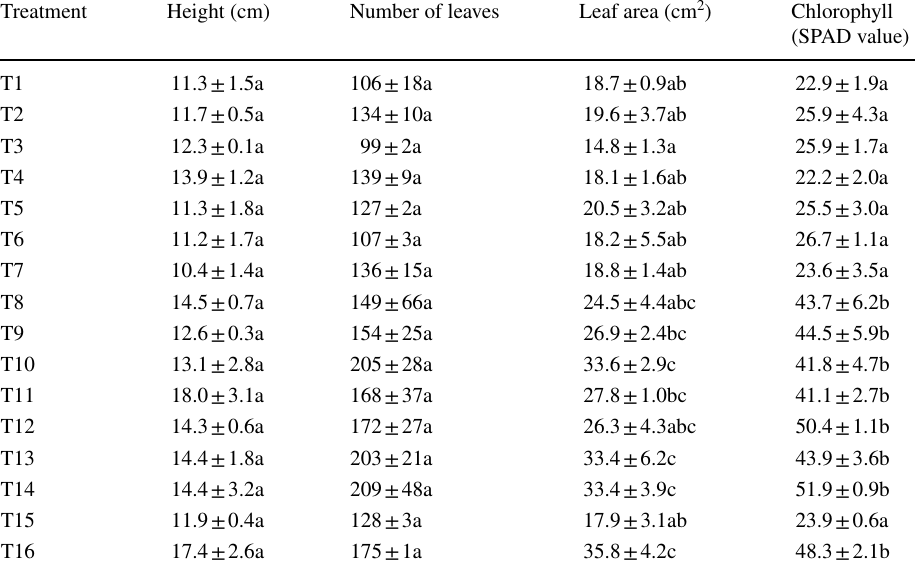
Values are the means of two replications and five plants per replicate Different letters show the significant differences according to Duncan’s test (P